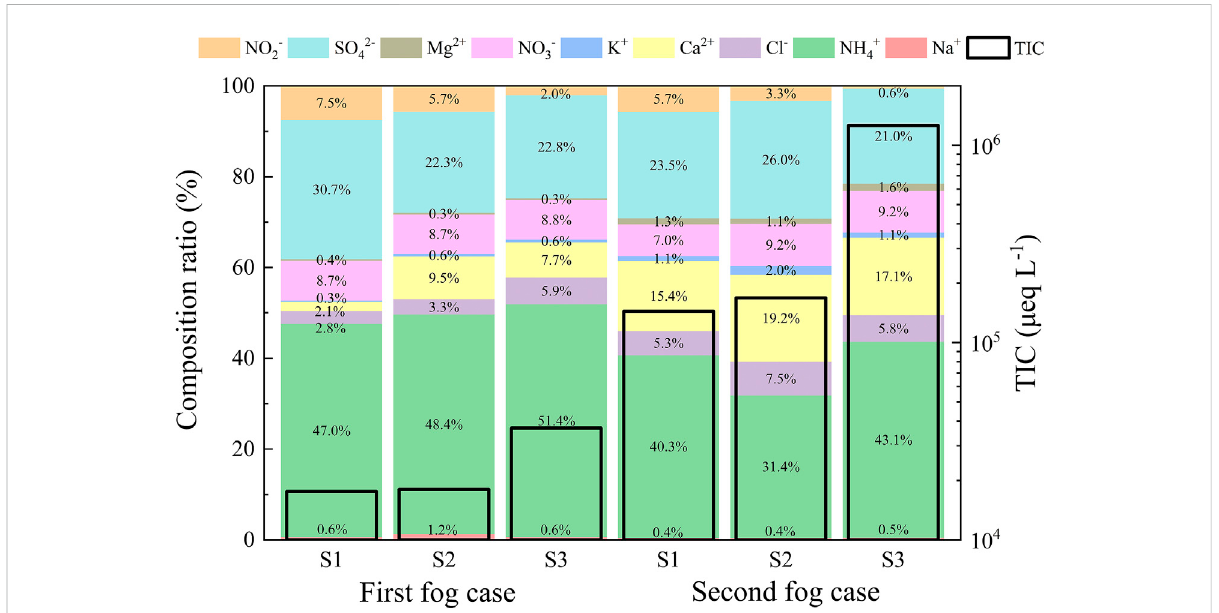
FIGURE 6 Total ion concentration (TIC) and the ratio of water-soluble ions in three-stage fog water for two persistent fog cases. The S1, S2, and S3 represent the sample for the large droplets of diameter larger than 22 μ m, medium droplets of diameter within 16 – 22 μ m, and small droplets of diameter within 4 – 16 μ m,